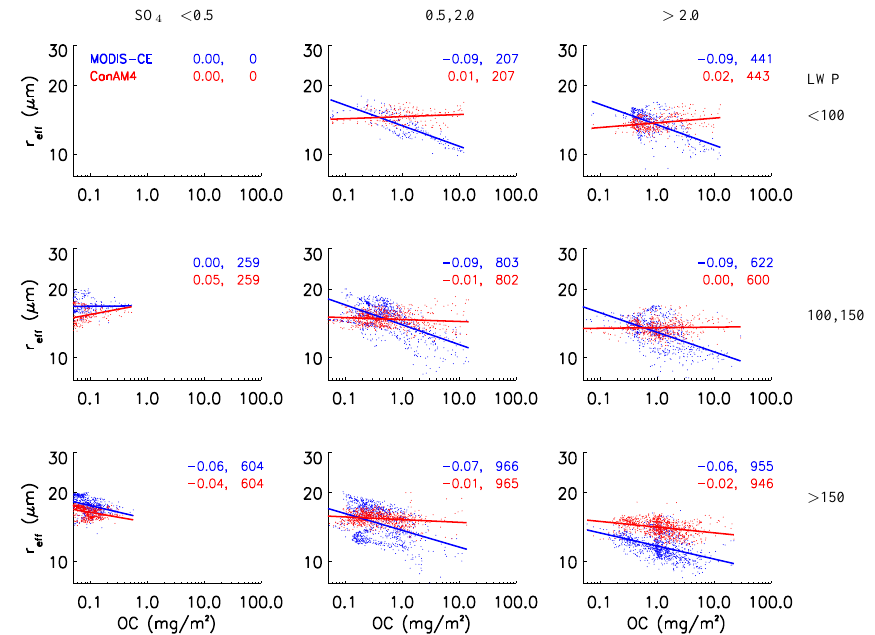
Fig. 5. Low (surface to 700hPa) cloud effective radius (in µm) from MODIS-CE (in blue) and CanAM4 simulation (in red) versus hydrophylic organic carbon (OC) in JJA. The data were stratified for 3 categories of liquid water path (LWP, in g/m 2 ), and 3 categories of sulphate (SO 4 , in mg/m 2 ). The slopes and numbers from linear regression are also marked in the plots.